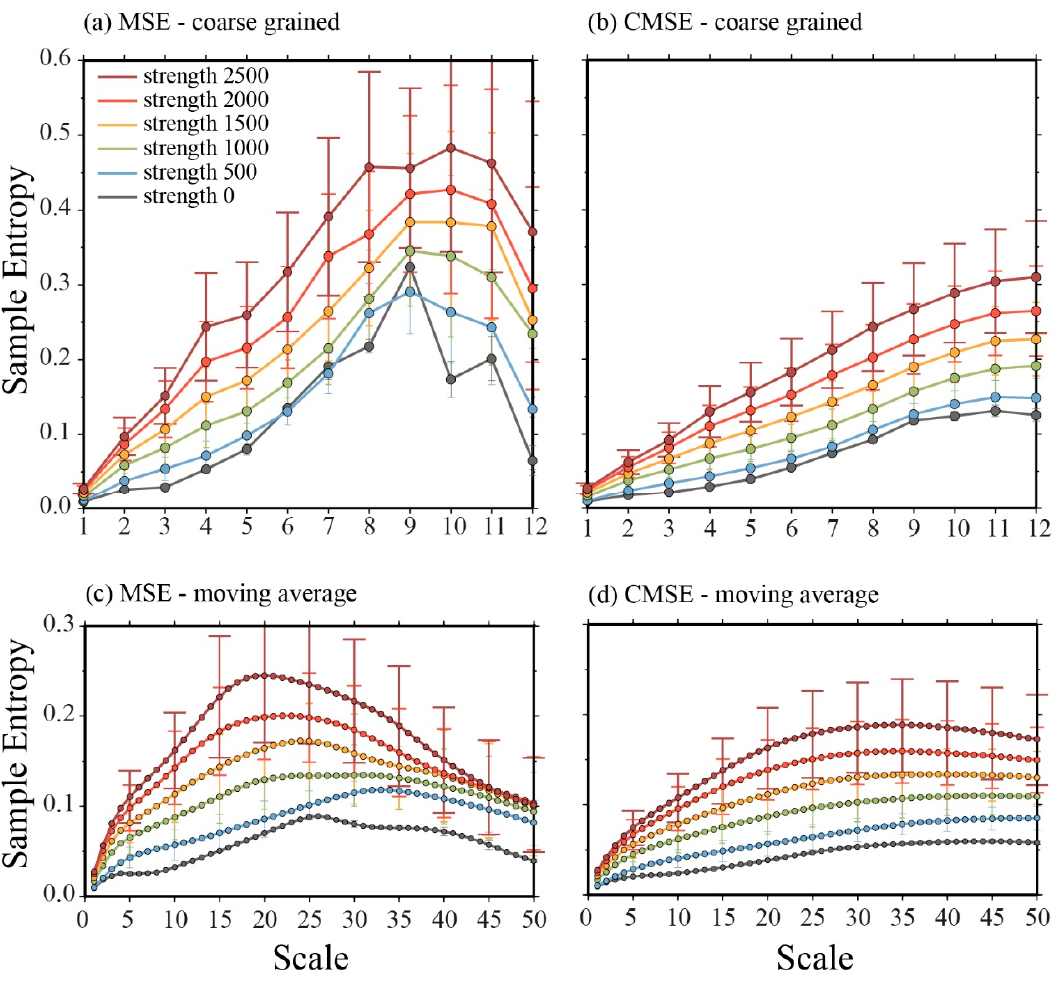
Figure 13. ( a ) MSE using a coarse-graining approach. ( b ) CMSE using a coarse-graining approach. ( c ) MSE using a moving average approach. ( d ) CMSE using a moving average approach. In each panel, the average of the sample entropy is shown for 1-D synthetic seismograms where they are grouped by ULVZ strength. Here, we show results for strengths binned from 0–250 (gray), 500 ± 250 (light blue), 1000 ± 250 (green), 1500 ± 250 (orange), 2000 ± 250 (red), 2500 ± 250 (dark red). One standard deviation error bars are shown in panels ( a , b ) but are only shown for every 5 scales in panels ( c , d ) to increase clarity.